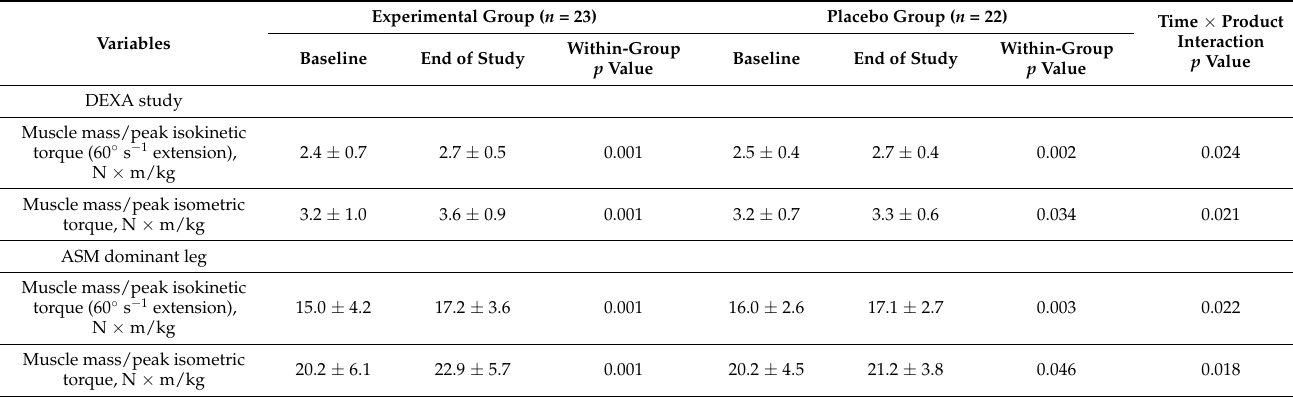
Table 4. Changes of muscle quality at the end of the study after 12 weeks of food supplementation with a spinach extract or placebo.